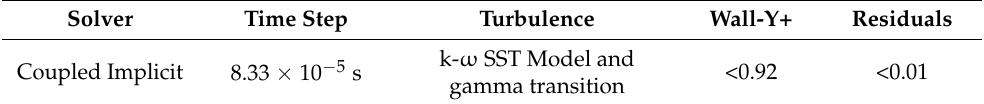
Table 5. Simulation setup, turbulence modeling, and convergence criteria.